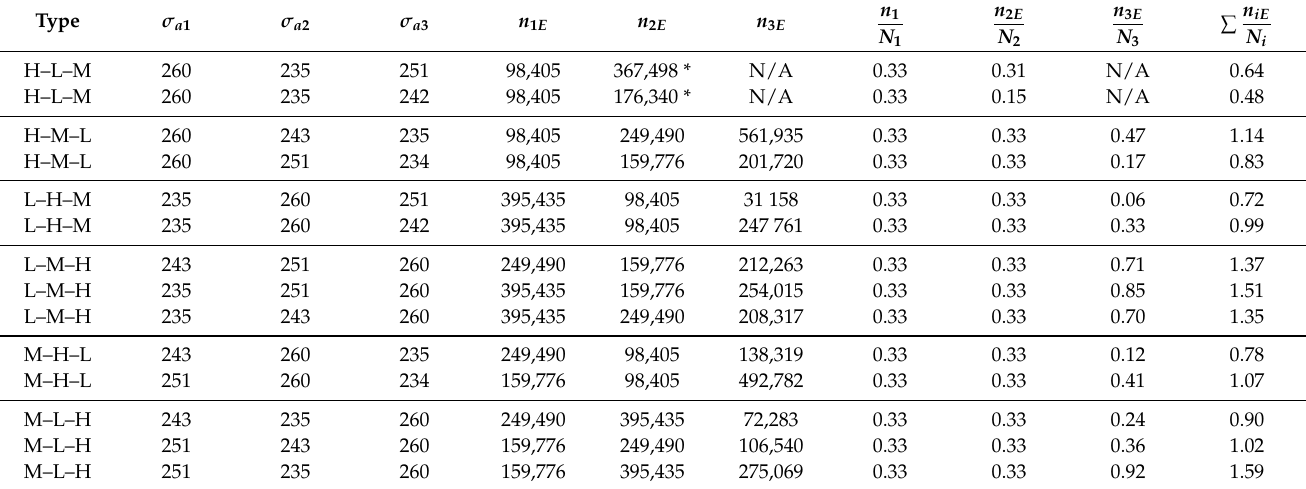
Table A8. Experimental results three-level block loading, specimens extracted from the rolling